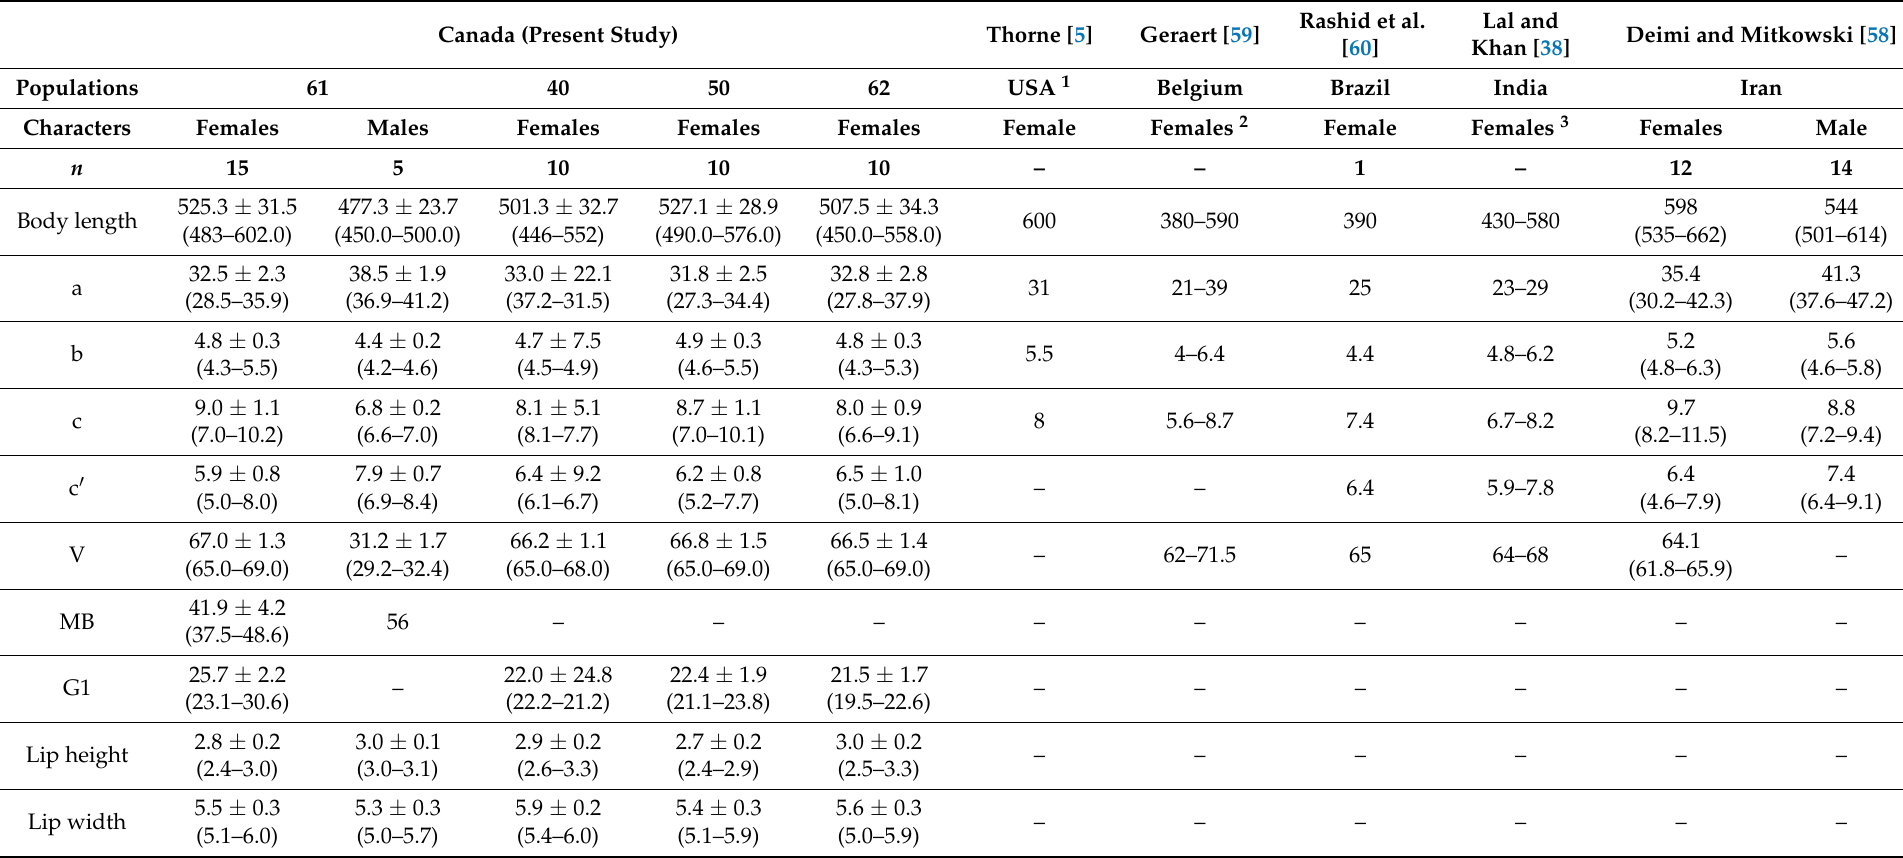
Table 3. Morphometrics of B. thylactus from Canada and other countries. All measurements are in µ m and presented as mean ± standard deviation